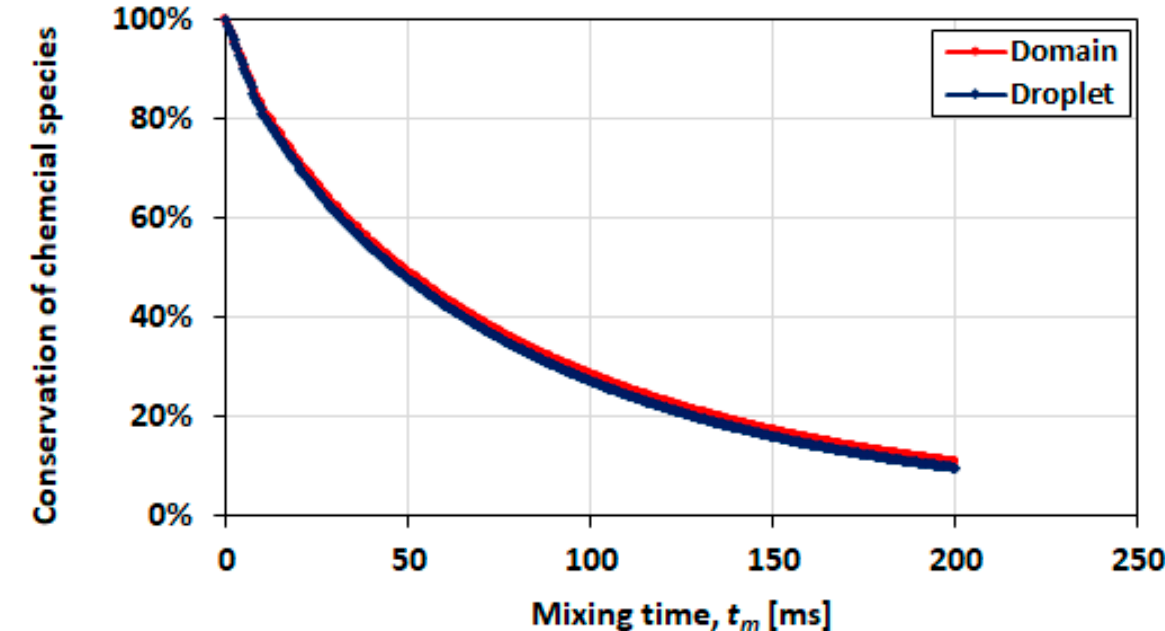
Figure 20. Conservation index for the diffusion-dominated mixing case = 0.018, λ = 2 .